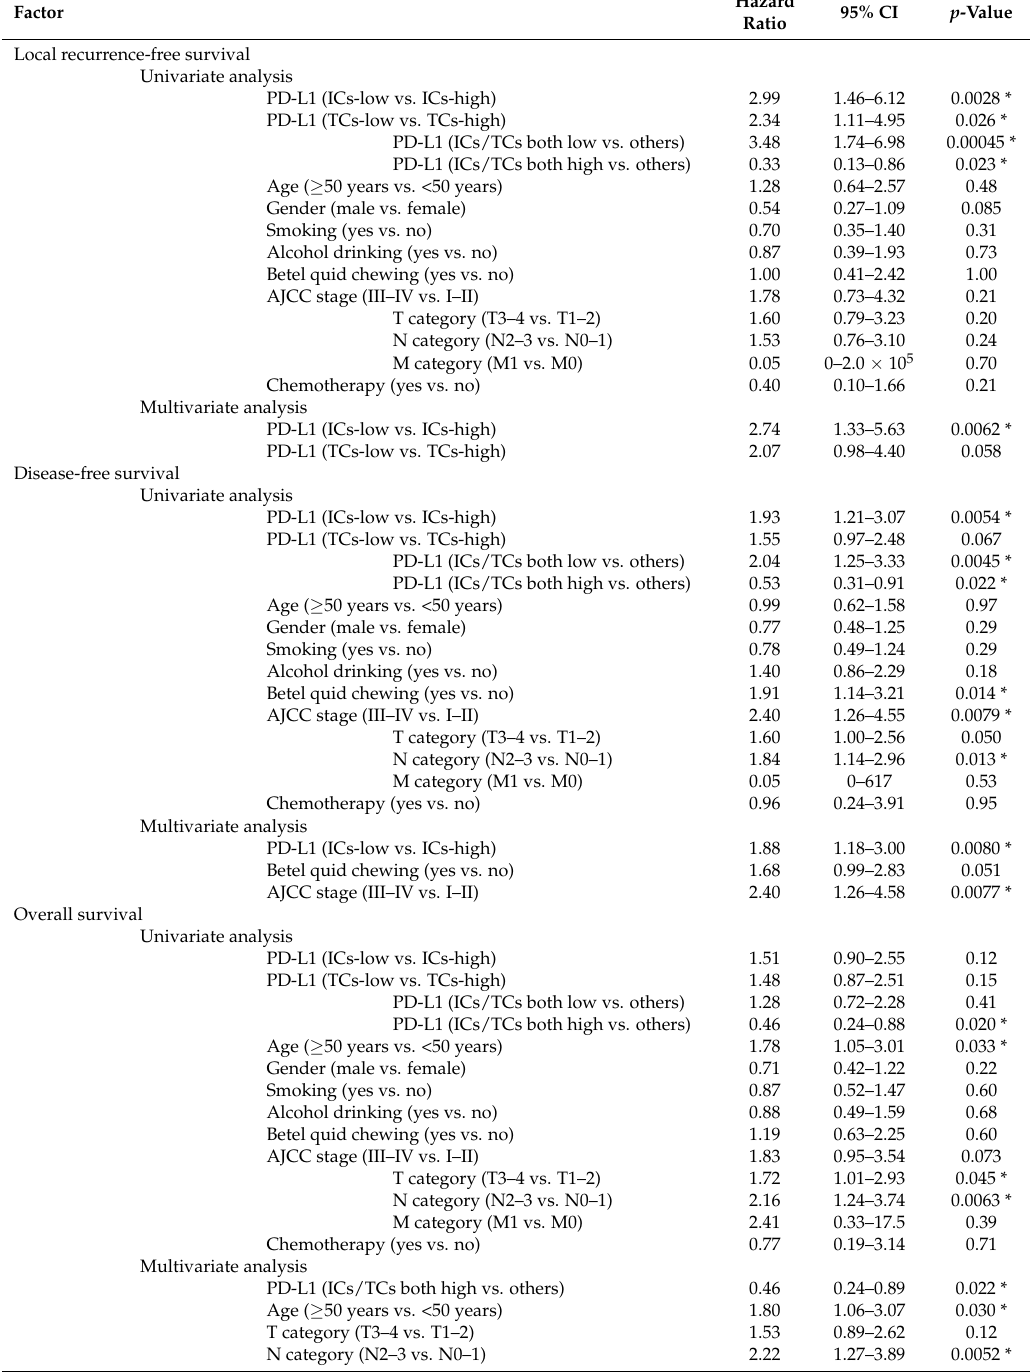
Table 2. Association between prognostic factors and